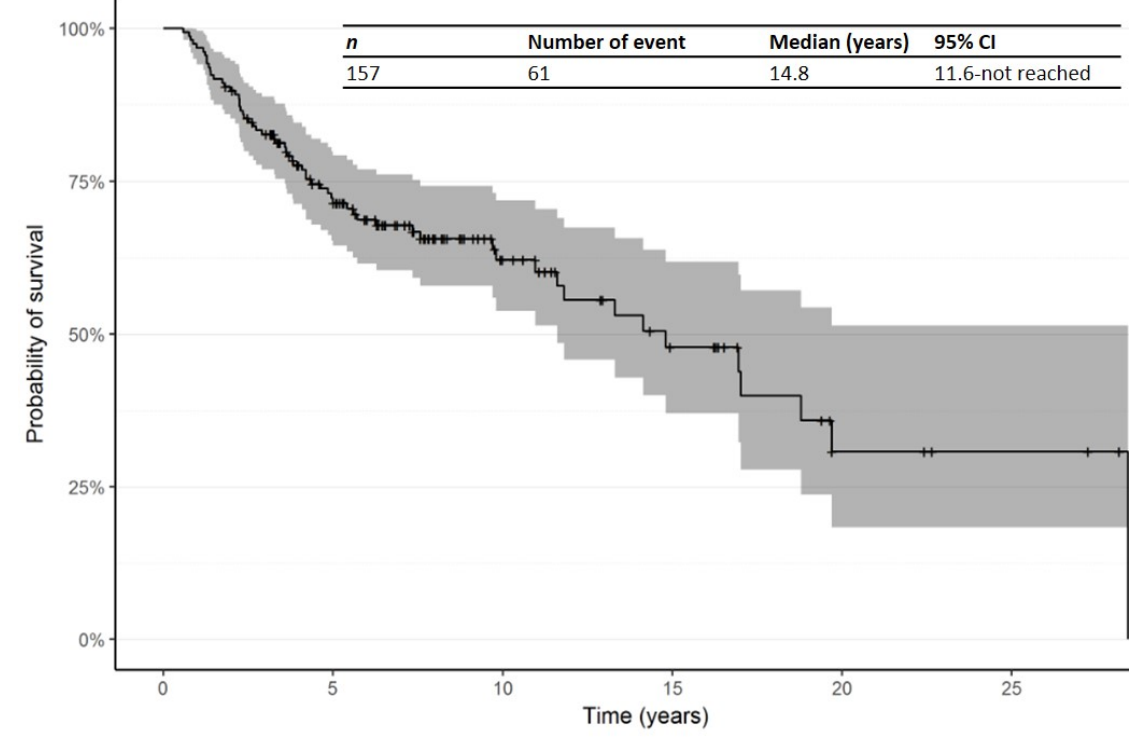
Figure 2. Kaplan–Meier curve for overall survival (OS) from time of diagnosis. Abbreviations: CI: confidence interval; OS: overall survival.